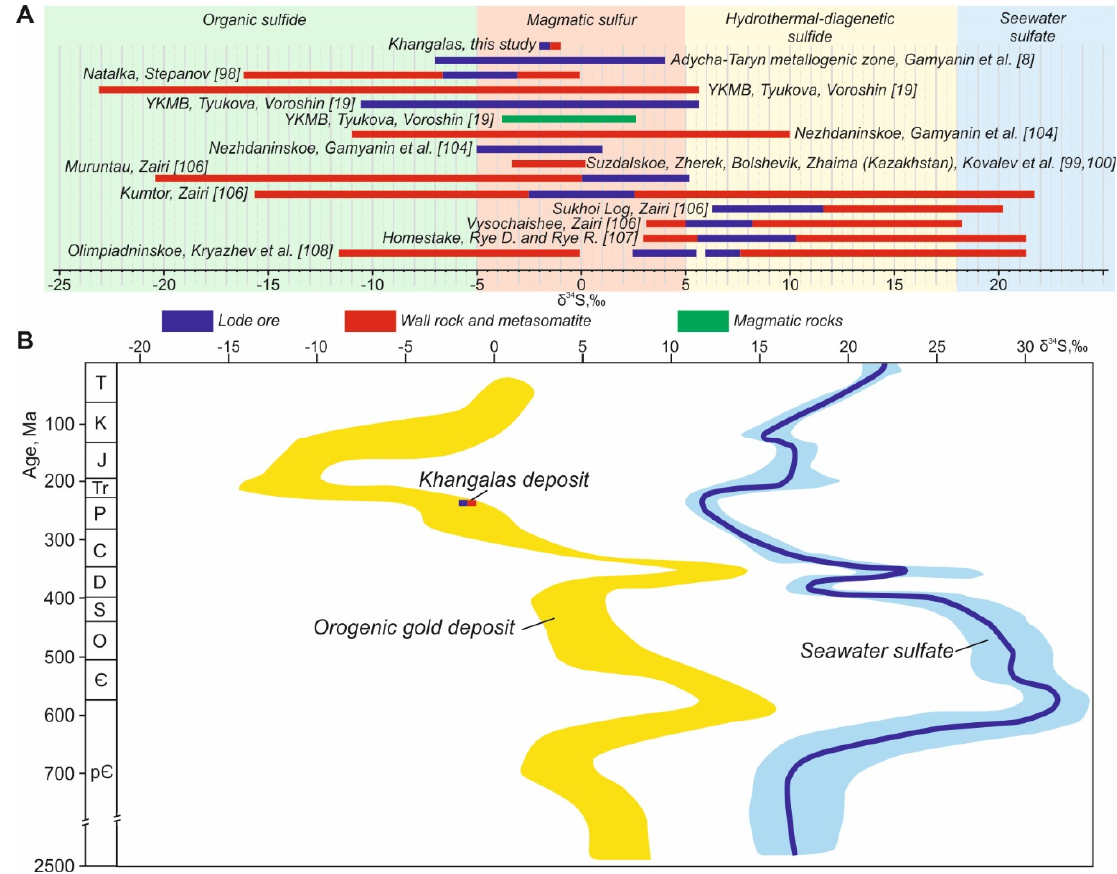
Figure 16. ( A ) S isotope composition of sulfides of Khangalas deposit [106–108]. Range of values of sulfur sources after Ohmoto [109] and Kryazhev [94]. ( B ) Variation in δ 34 S values of sulfides in global sediment-hosted orogenic gold deposits after Goldfarb et al. [96]. Heavy line and blue error envelope indicate seawater sulfate evolution curve from Claypool et al. [110].